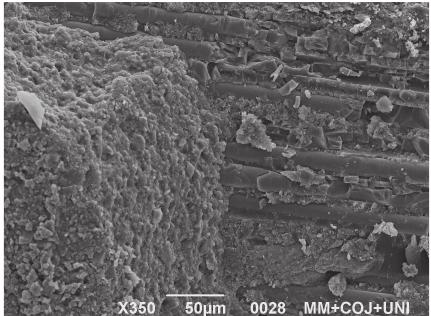
Figure 7: SEM image of the post surface after pull-out test (sample in group 2). A portion of RelyX Unicem on the post surface (350x) is